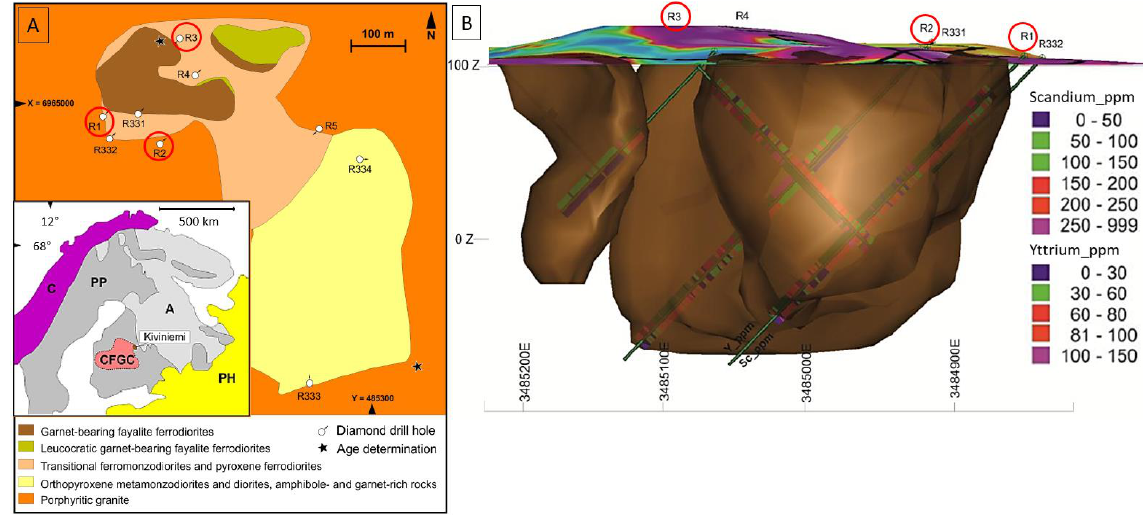
Figure 2. ( A ) Geological map of the Kiviniemi intrusion with the location and direction of drill holes [11]. Drill cores included in this study indicated with red circles. ( B ) Fayalite ferrodiorite blocks of the Kiviniemi intrusion, view from the north (modified from [16], printed with the permission from GTK) .